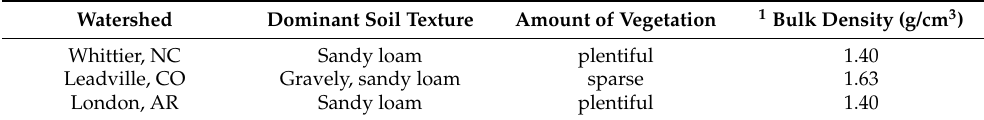
Table 1. Bulk densities assigned to each watershed based on dominant soil texture and vegetation [38]. Watershed Dominant Soil Texture Amount of Vegetation Whittier,